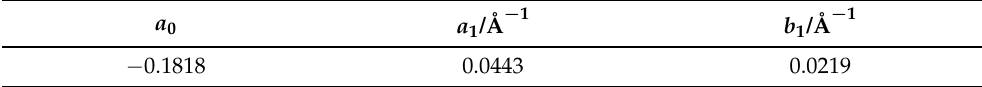
Table 1. Results of the fitting of the data in Figure 5 to the Padé approximant in Equation (3). − a 0 a 1 /Å